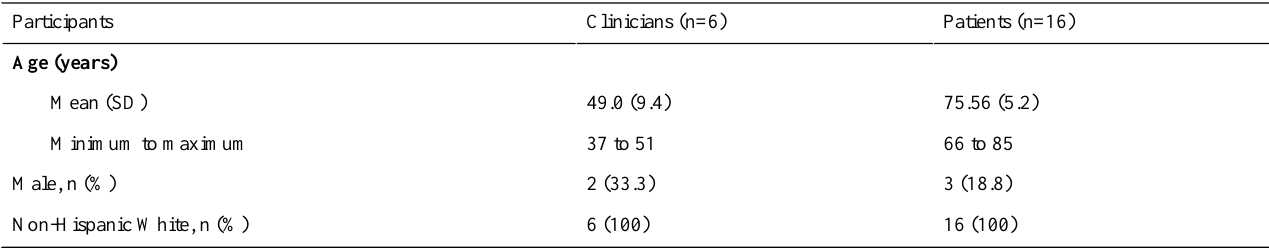
Table 1. Study participant characteristics